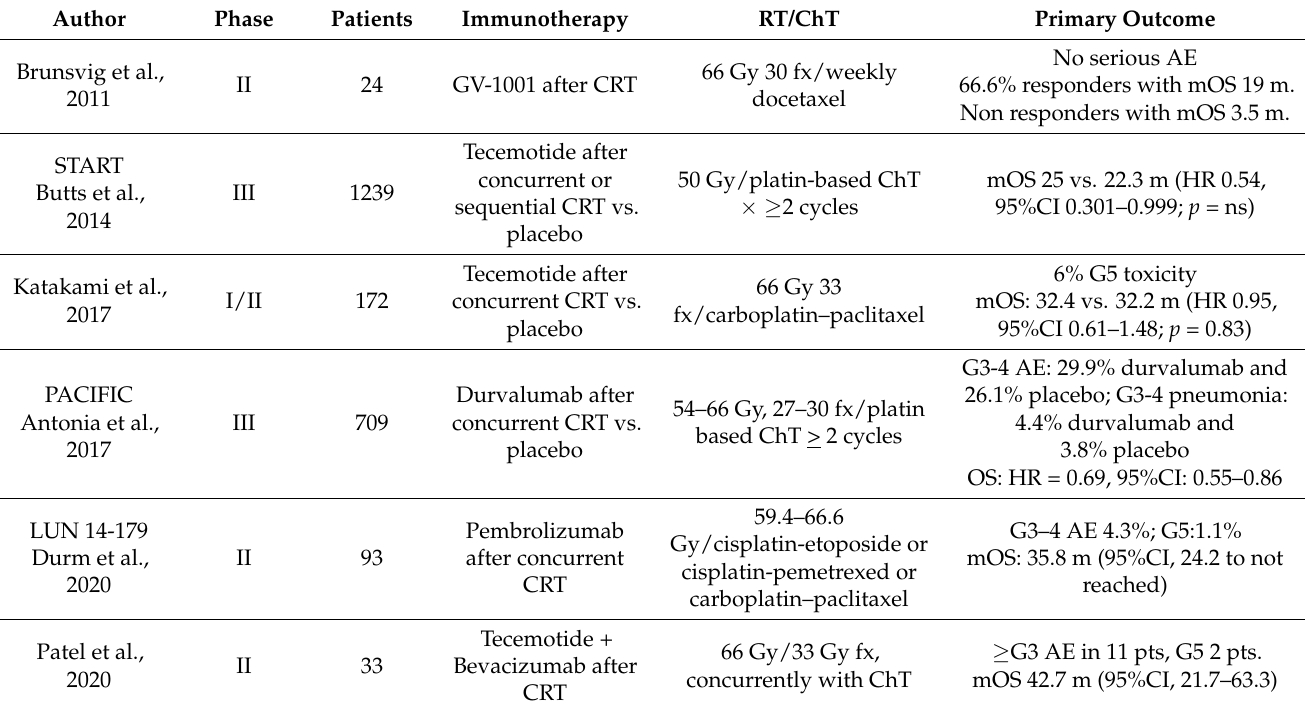
Table 5. Studies evaluating sequential immunotherapy with radiotherapy in stage III